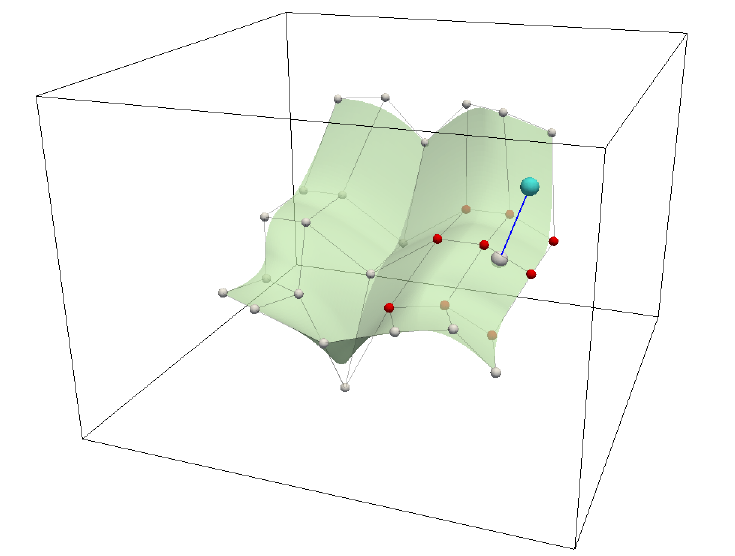
Figure 2. Behavioral analysis in the presence of complex free form embedded surface. The spatial point may only influence a local region of the surface with the highlighted control points, which can be identified by point